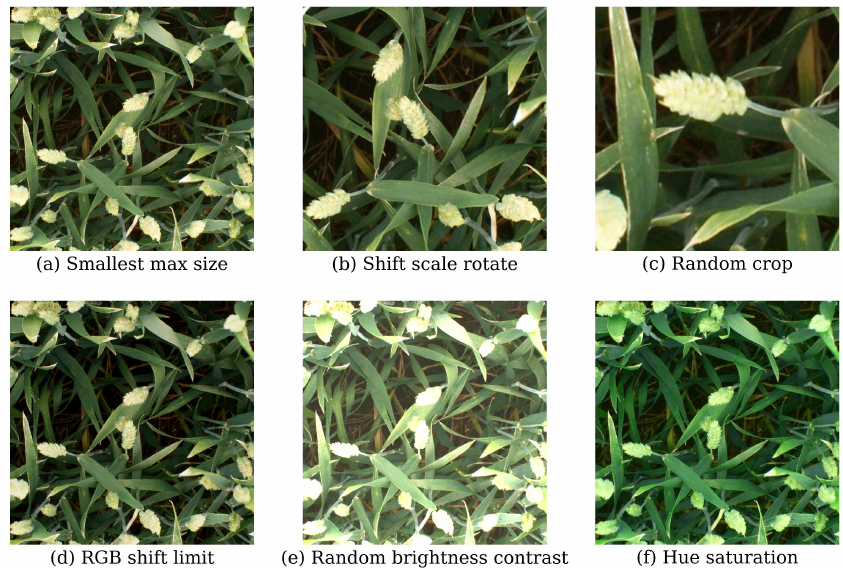
Figure 9. Sample images from the augmented training